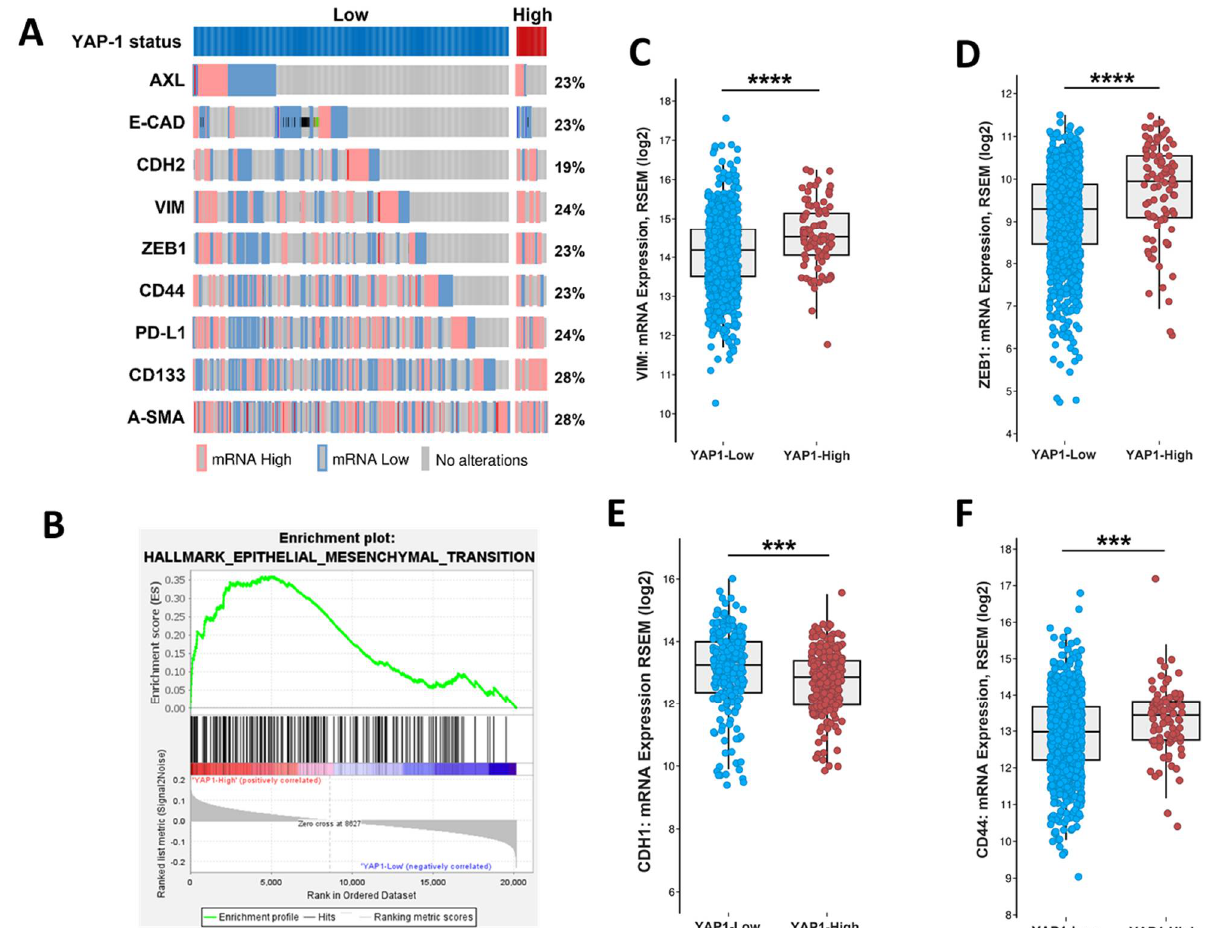
Figure 2. In silico data analysis between samples expressing high and low levels of YAP1. ( A ) The oncoprint plot depicts the high expression of EMT- and stemness-related genes in samples with YAP1-high status at the transcriptome level. ( B ) The gene-set enrichment analysis (GSEA) shows the enrichment of hallmarks of EMT in samples with a high level of YAP1. ( C – F ) The comparison between high and low YAP1 groups in terms of VIM expression ( C ), ZEB1 ( D ), CDH1 ( E ), and CD44 ( F ). *** p < 0.0002, **** p < 0.0001 using student t -test.